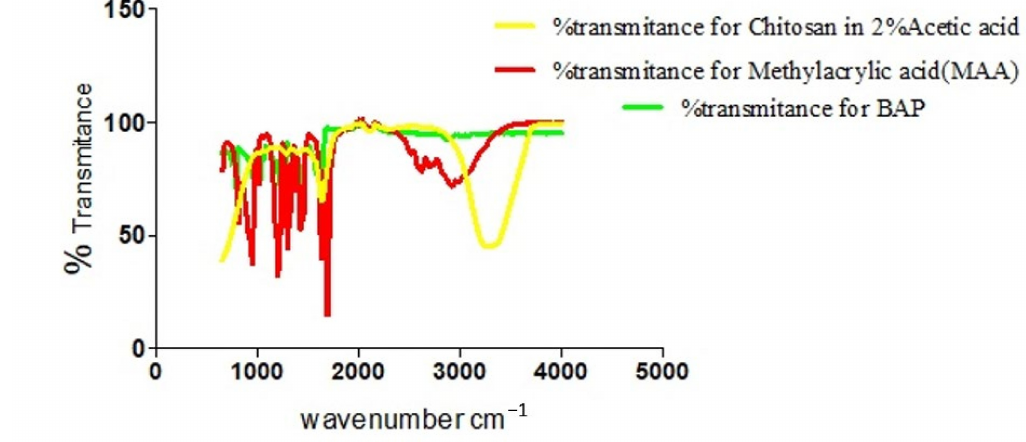
Figure 10. Overlay of spectra of % transmittances against wavenumbers for Chitosan, MAA and